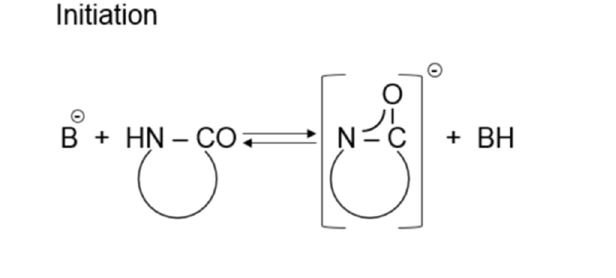
( c ) Figure 4. Initiation ( a,b ) and propagation ( c ) of the AROP of ε‐ CL (Note: x = 5), reprinted from [1] under open access license. 3.2. Polymerization Kinetic Models The polymerization kinetics of the AROP of CL can be described in two ways—mechanistic and semi ‐ empirical. The mechanistic approach [40–47] takes into account all the side reactions, and due to the complex nature of AROP, it is impractical. The semi ‐ empirical approach lumps all reactions into a single step and describes them in a single Arrhenius ‐ based rate equation, without much consideration of reaction chemistry. Therefore, the semi ‐ empirical approach is mostly used for the kinetic description of AROP. The rate equation is semi ‐ empirical, and its constants should be